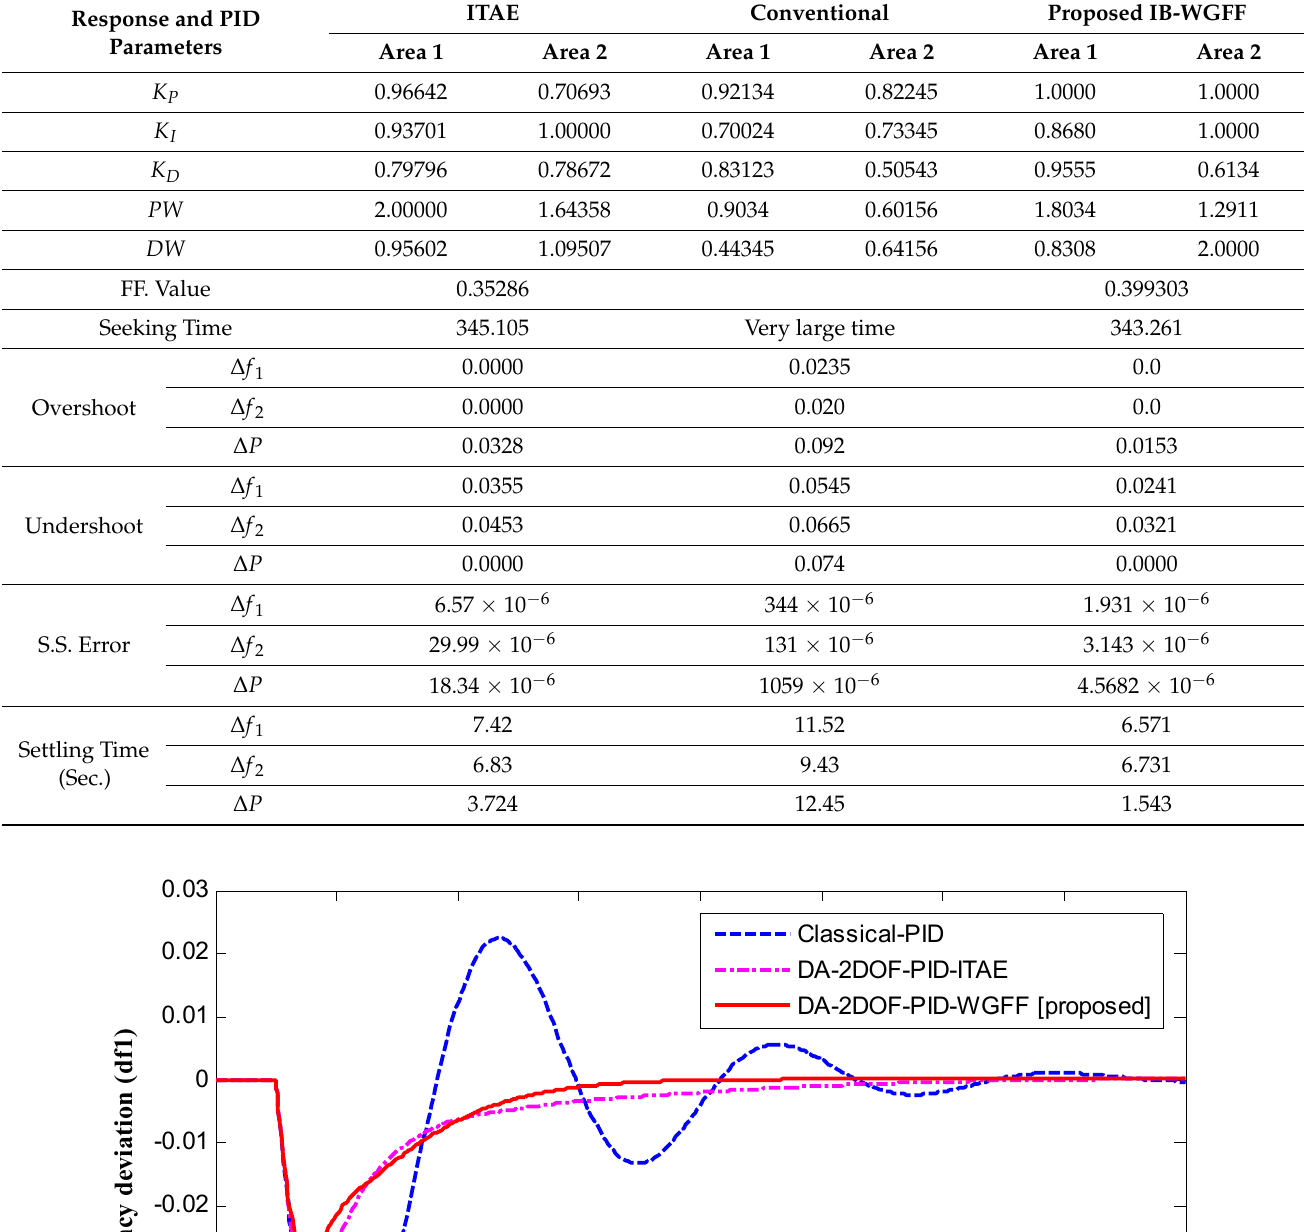
Table 7. Efforts using conventional 2-DOF-PID, DA-2-DOF-PID-ITAE, and DA-2-DOF-PID-IB-WGFF.